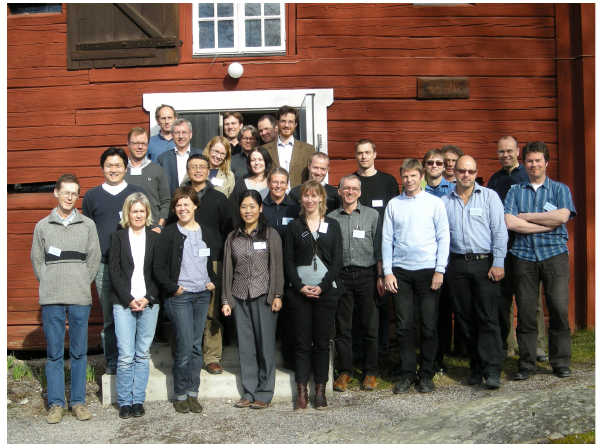
Fig. 1. Workshop participants. Photo: Anders